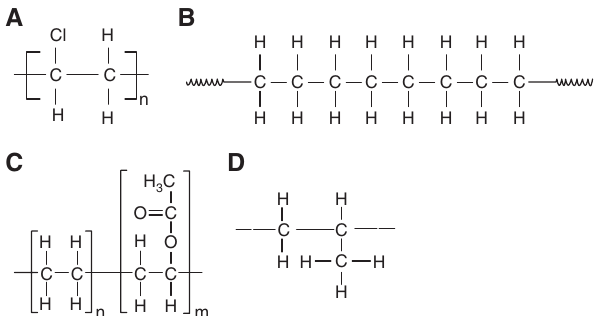
Figure 1 Chemical structures of polymers used for the present analysis. (A) PVC, (B) HDPE, (C) EVA and (D)